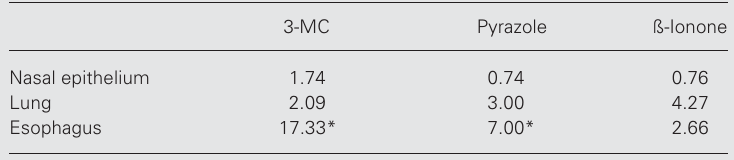
The rats were treated with 25 mg/kg 3-methylcholanthrene (3-MC), 150 mg/kg pyrazole and 1 g/kg ß-ionone ip daily for 4 days. Data are reported as “fold” increase compared to respective controls. *P < 0.05 compared to respective control (Student t